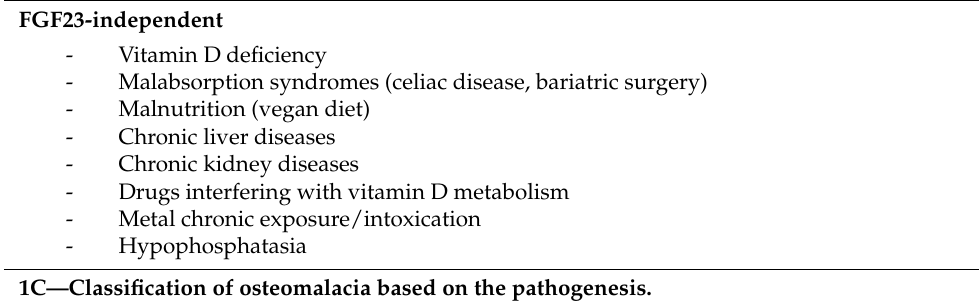
Table 1. Cont. FGF23-independent -